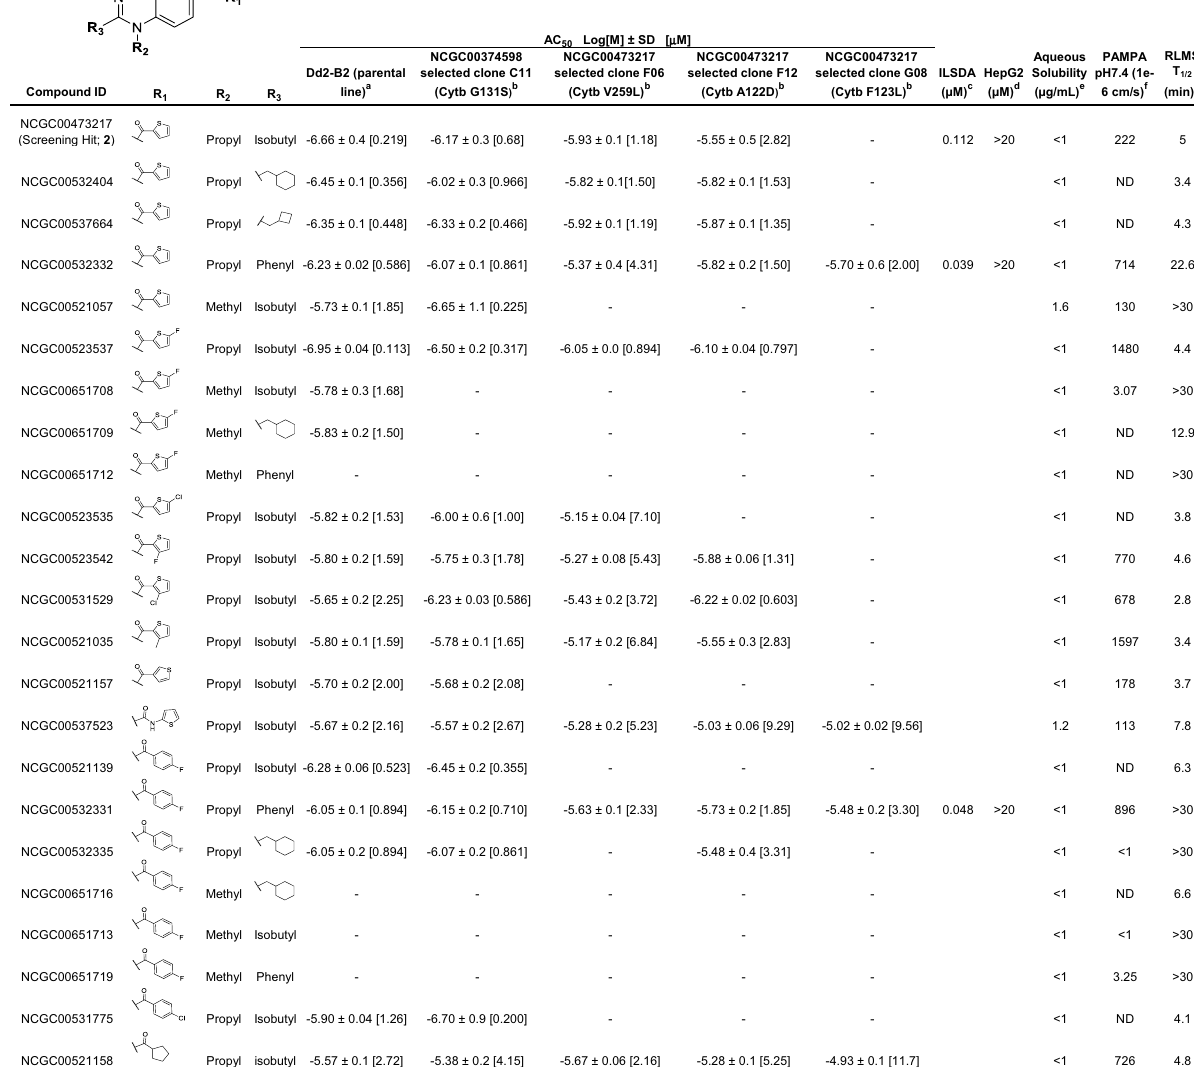
Table 1. Thiadiazine analog potencies and early in vitro ADME properties. a P. falciparum Dd2 (clone B2) activity in SYBR Green based 72 h in vitro proliferation assay; shown is the AC 50 value expressed Log[M] ± SD, of at least three independent assays, then expressed in brackets as approximate value in µM. b (-), indicates no activity or efficacy in the assay in the concentration range tested (highest concentrations of 29 µM). c Inhibition of liver-stage development assay potency, 48 h assay employing a firefly luciferase reporter P. berghei line. d Mammalian cellular toxicity assessed against HepG2 cells, 48 h compound exposure. Pharmacokinetic modeling experiments preformed as described previously— e aqueous solubility 65 . f Parallel artificial membrane permeability assay (PAMPA) 64 . ND (not detectable), indicates compound not detectable, could reflect insolubility, non-specific binding, compound being stuck in the lipid bi-layer, etc. g Rat liver microsomal stability (RLMS) in microsomes 66